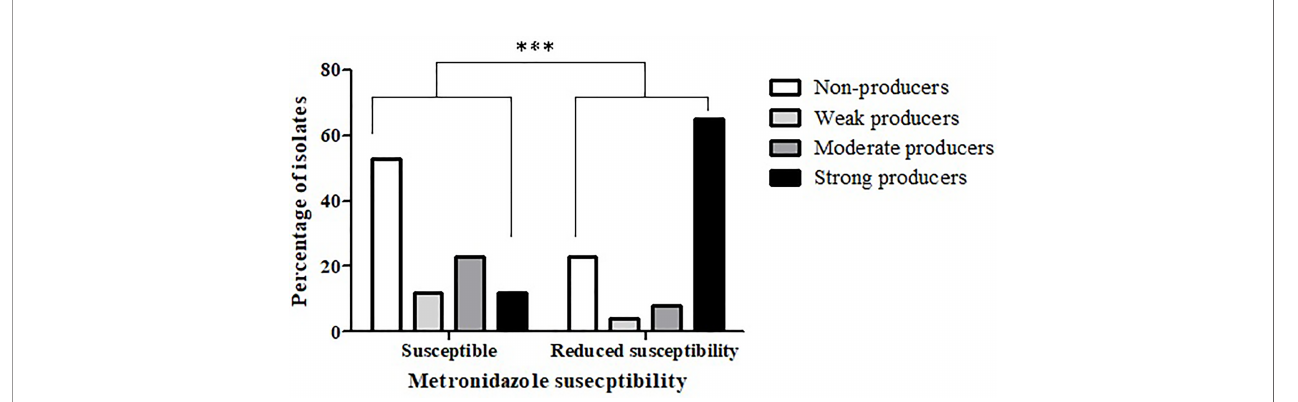
FIGURE 1 | Bio fi lm production capacity among metronidazole-susceptible isolates and isolates with reduced susceptibility. The bio fi lm production capacity of C. dif fi cile isolates was compared between metronidazole-susceptible (n = 96) and reduced metronidazole susceptibility isolates (n = 27) (*** p < 0.0001). The p value represents the comparison of the bio fi lm production capacity between susceptible isolates and isolates with reduced susceptibility (Chi square